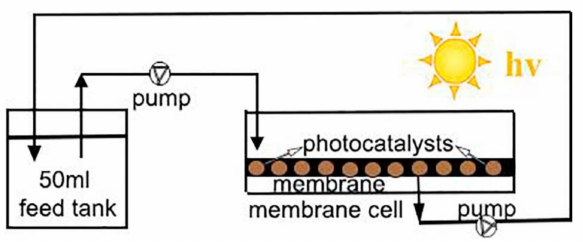
Figure 11. Schematic drawing of the PMR setup with a dead-end UF system with an active membrane area of 8.5 cm 2 used by Yu et al. Reprinted with permission from ref. [147]. Copyright © 2021 Elsevier